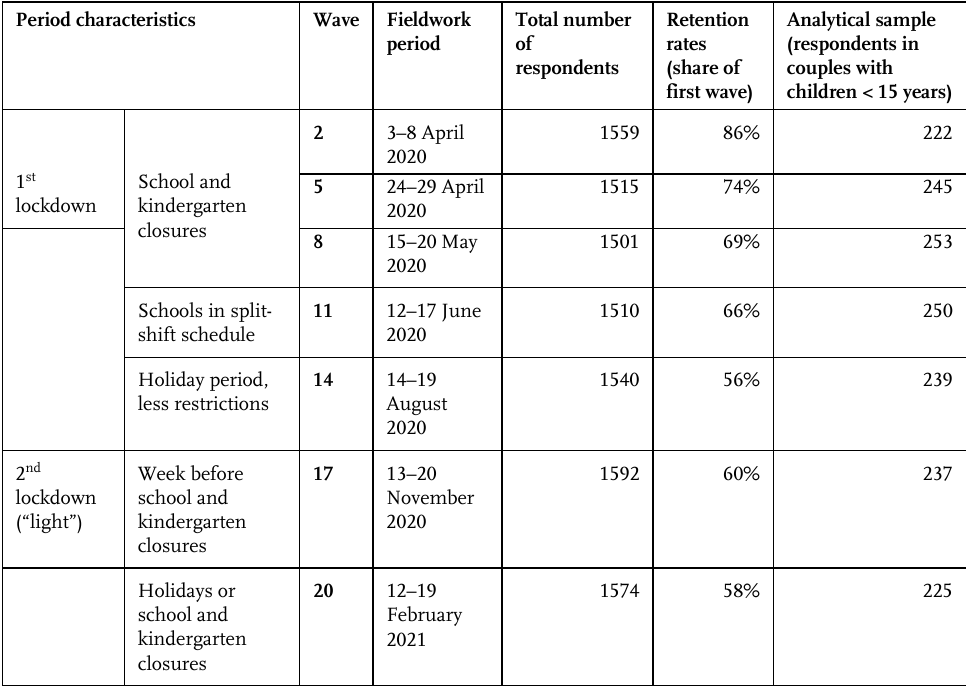
Table 2 : ACPP survey wave